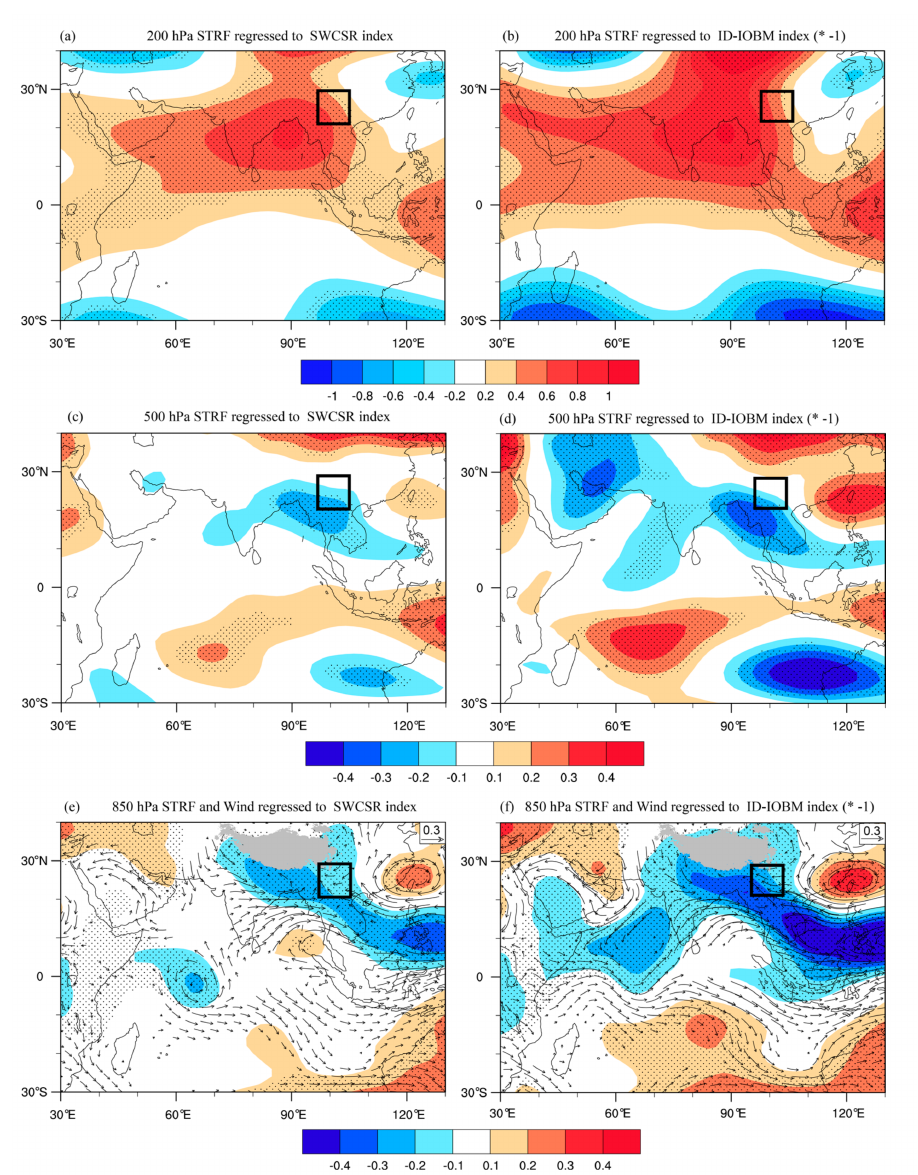
Figure 4. Stream function (STRF, shading; 10 6 m 2 /s) regressed against the SWCSR index and the ID-IOBM index at ( a , b ) 200 hPa and ( c , d ) 500 hPa; and ( e , f ) regressed STRF (shading; 10 6 m 2 /s) and wind field (vectors; m/s) anomalies at 850 hPa in June, July, and August (JJA). “*” denotes “multiply by”. Black dots denote areas significant at the 95% confidence